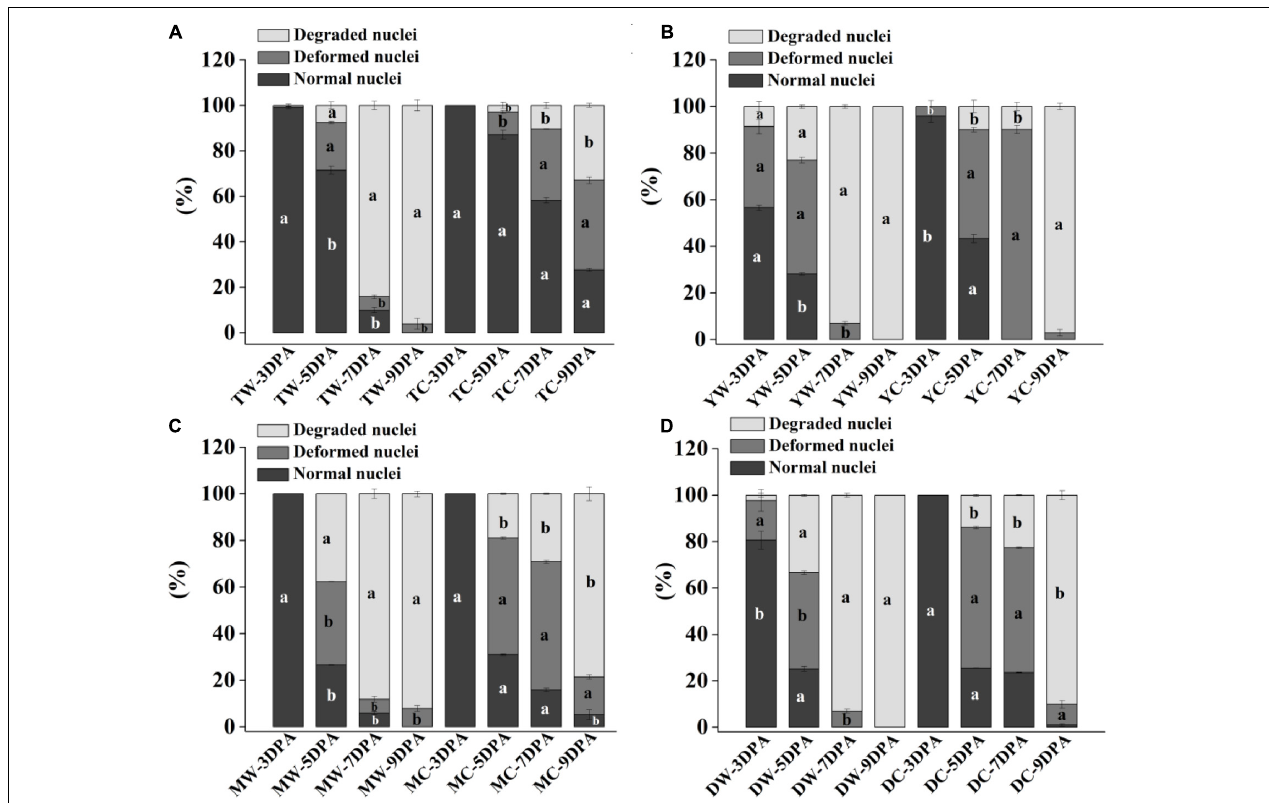
FIGURE 2 | Proportion of normal, deformed, and degraded nuclei in endosperm cells of weedy and cultivated rice. (A) Weedy and cultivated rice from Taizhou; (B) weedy and cultivated rice from Yangzhou; (C) weedy and cultivated rice from Maoming; (D) weedy and cultivated rice from Dandong. TW, weedy rice from Taizhou; TC, cultivated rice from Taizhou; YW, weedy rice from Yangzhou; YC, cultivated rice from Yangzhou; MW, weedy rice from Maoming; MC, cultivated rice from Maoming; DW, weedy rice from Dandong; DC, cultivated rice from Dandong. DPA, days post-anthesis. Different lowercase letters indicate statistical significance for the comparison between weedy rice and its associated cultivated rice (independent-sample t -test, P < 0.05). The data are presented as mean ± SE ( n =